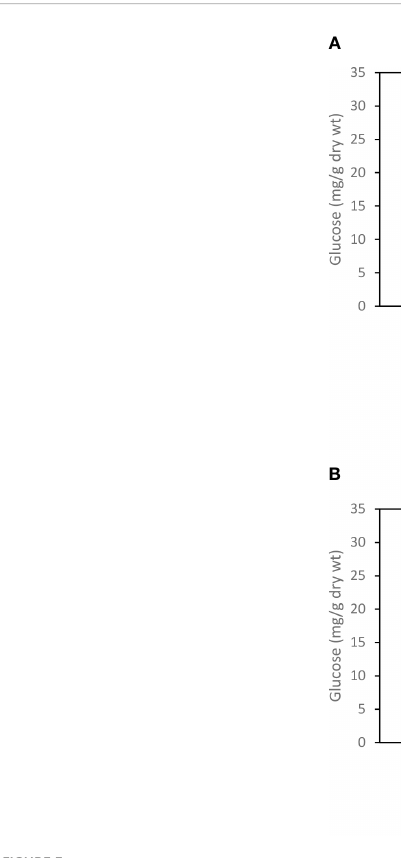
FIGURE 3 Effect of ABA on the bud concentrations of glucose in greenhouse-grown grapevines (A) ‘ Chambourcin ’ and (B) ‘ Cabernet franc ’ . Bars with different letters are signi fi cantly different at p ≤ 0.05. (n = 4). Standard errors are